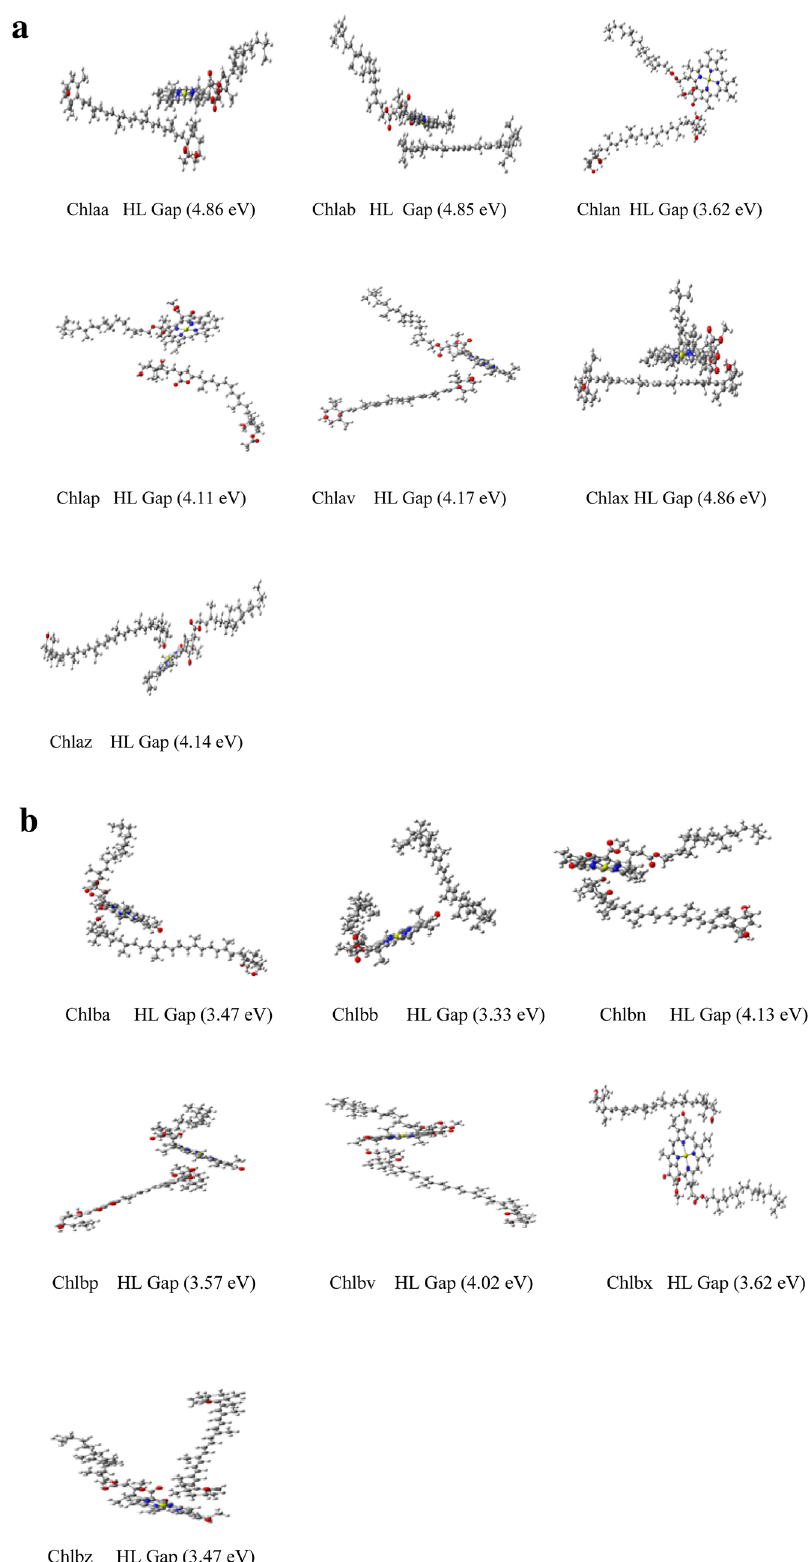
Figure 2. ( a ) Optimized Structures of Chylla-carotenoid complexes with wB97xD/Lanl2dz:6-31G** basis sets in solvent (water) by DFT method. ( b ) Optimized Structures of Chyllb-carotenoid complexes with wB97xD/ Lanl2dz:6-31G** basis sets in solvent (water) by DFT